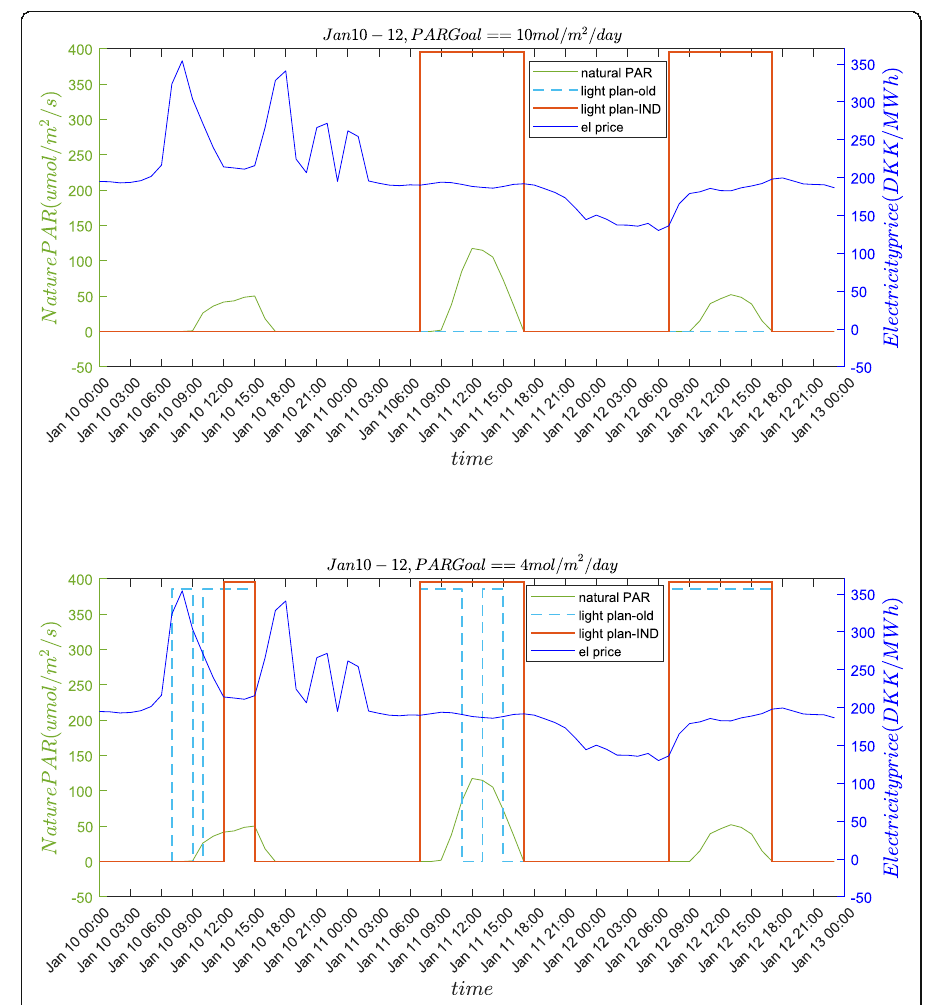
Fig. 5 simulation results on Jan 10 – 12. a PAR goal = 10 mol / m 2 / d . b PAR goal = 4 mol / m 2 /